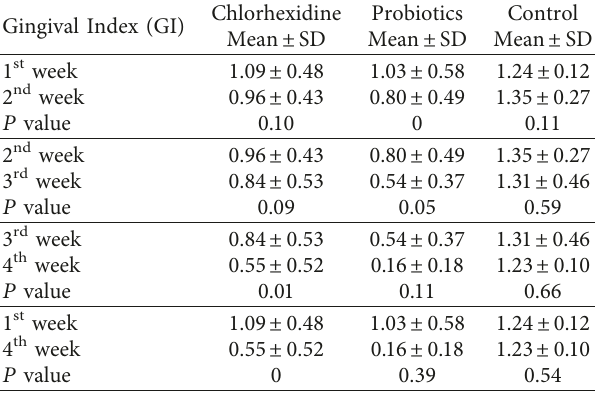
Table 2: Comparison of the mean gingival value scores between the groups.